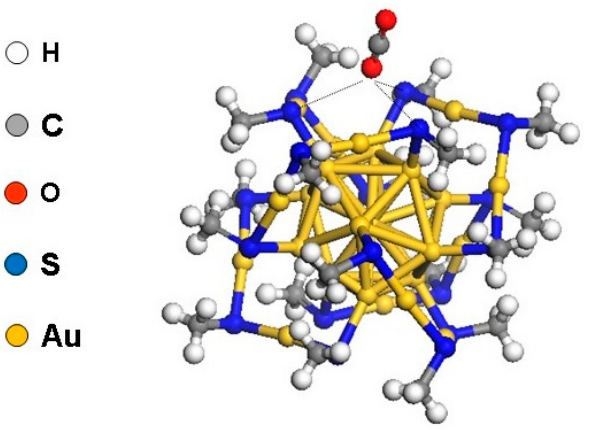
Figure 2. CO 2 adsorbed on Au 25 (SCH 3 ) 18 − nanocluster. Adapted from Reference [39]. Copyright 2012 by the American Chemical Society.